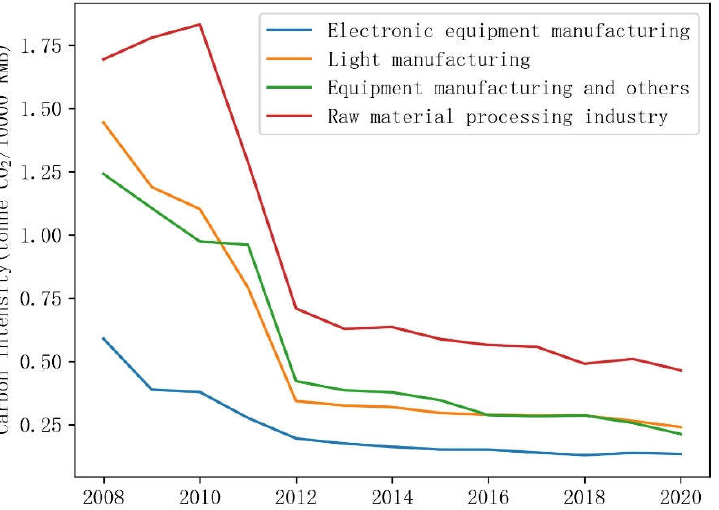
Figure 5. Trend of carbon intensity of Shenzhen’s manufacturing sector by four categories during 2008–2020 .